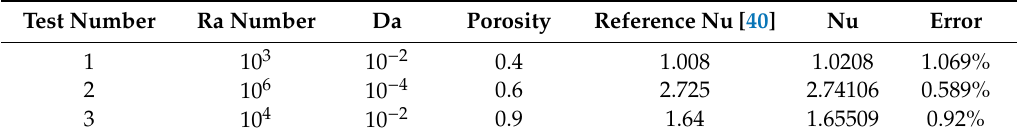
Table 2. The comparison of the results of the present study with the reference.